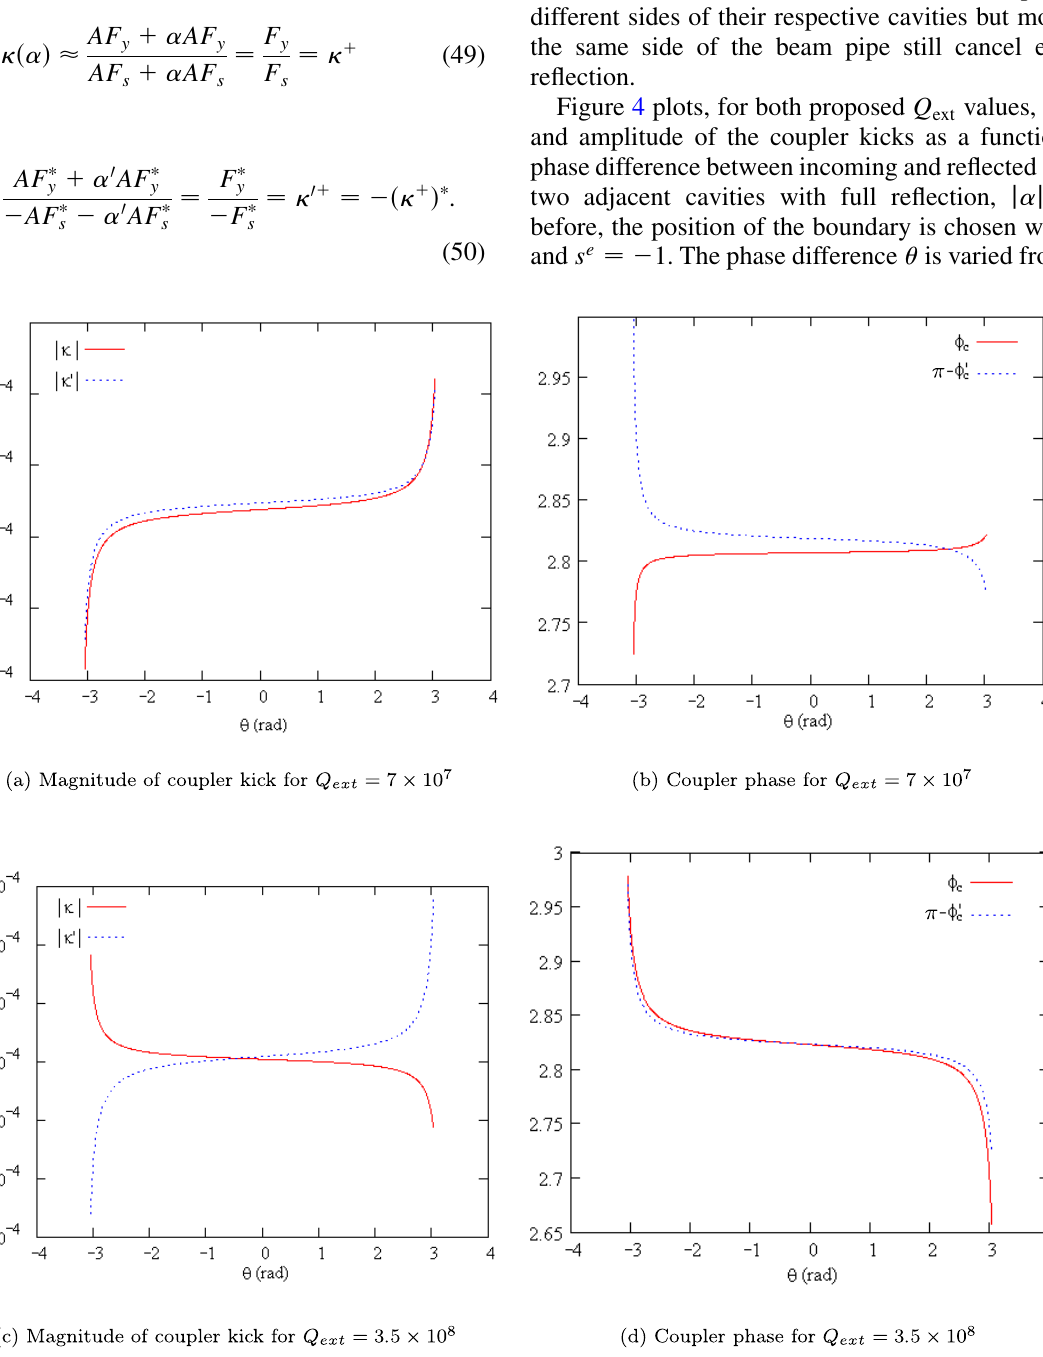
FIG. 4. (Color) Coupler kick for couplers situated before and after the cavity, the latter signified by a prime, as functions of the phase difference (cid:12) between incoming and reflected